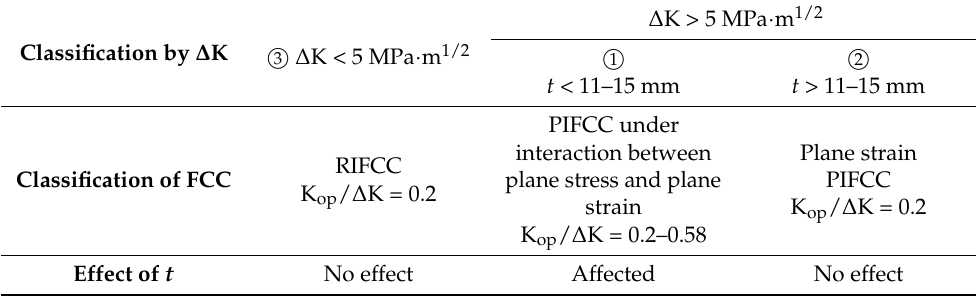
Table 3. Effects of t and ∆ K on K op